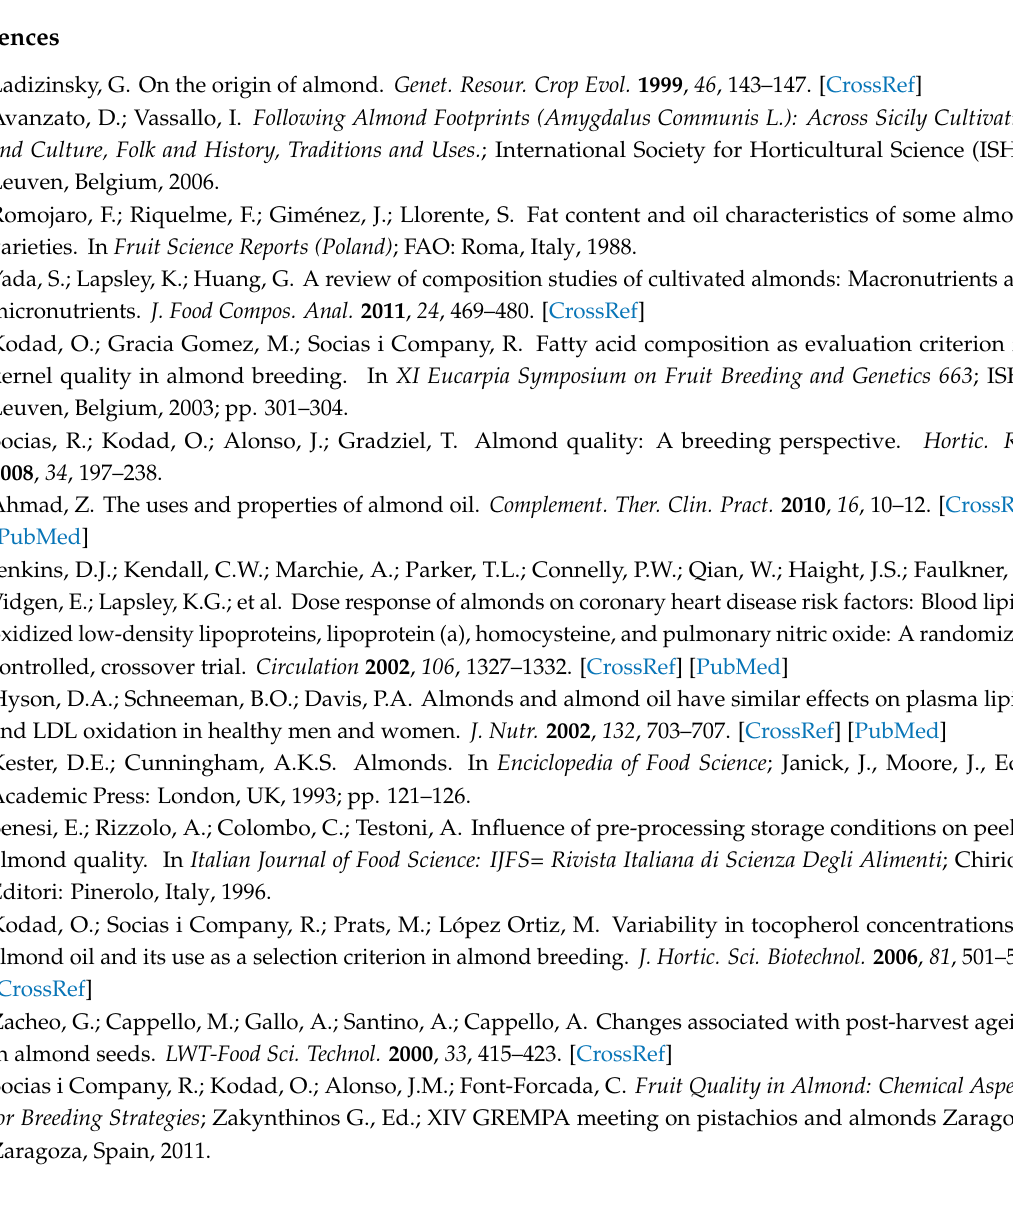
Table S1: Additional detail on morphological, agronomic, and oil-related traits; Table S2: Eigenvalue and Eigenvectors of PCA; Table S3: Primer sequences and annealing temperatures. Supplemental file S1 reports additional information on cultivars used in genetic structure analysis and on best K